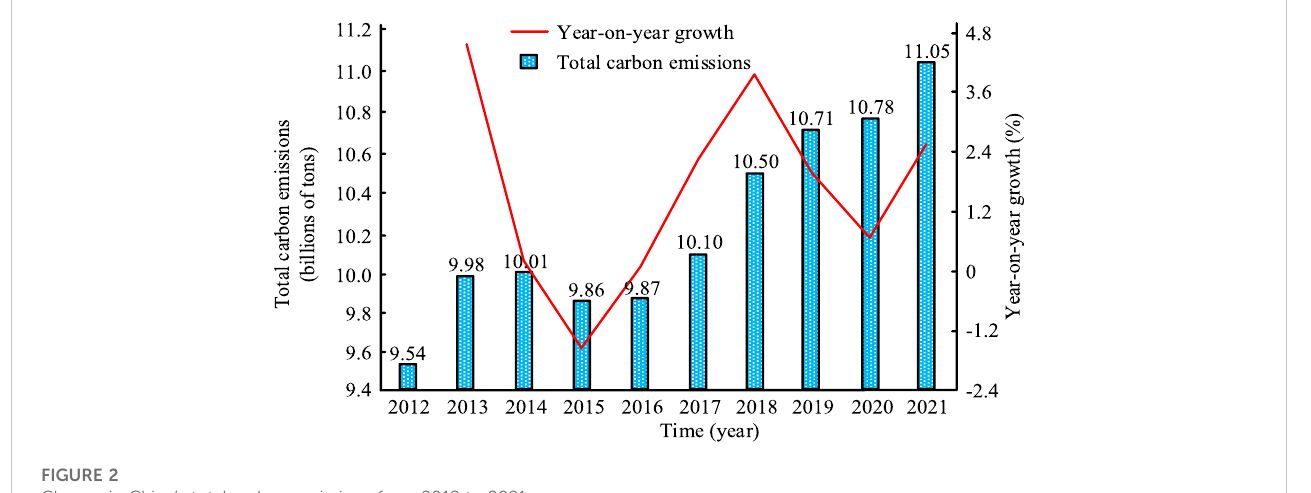
FIGURE 2 Change in China ’ s total carbon emissions from 2012 to